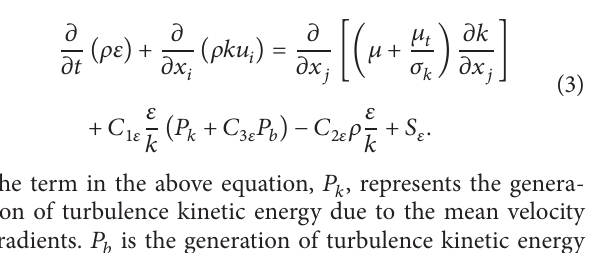
Here, 𝜌 is the density, 𝑝 is the static pressure, ⃗ V is the velocity tensor, and 𝜏 is the stress